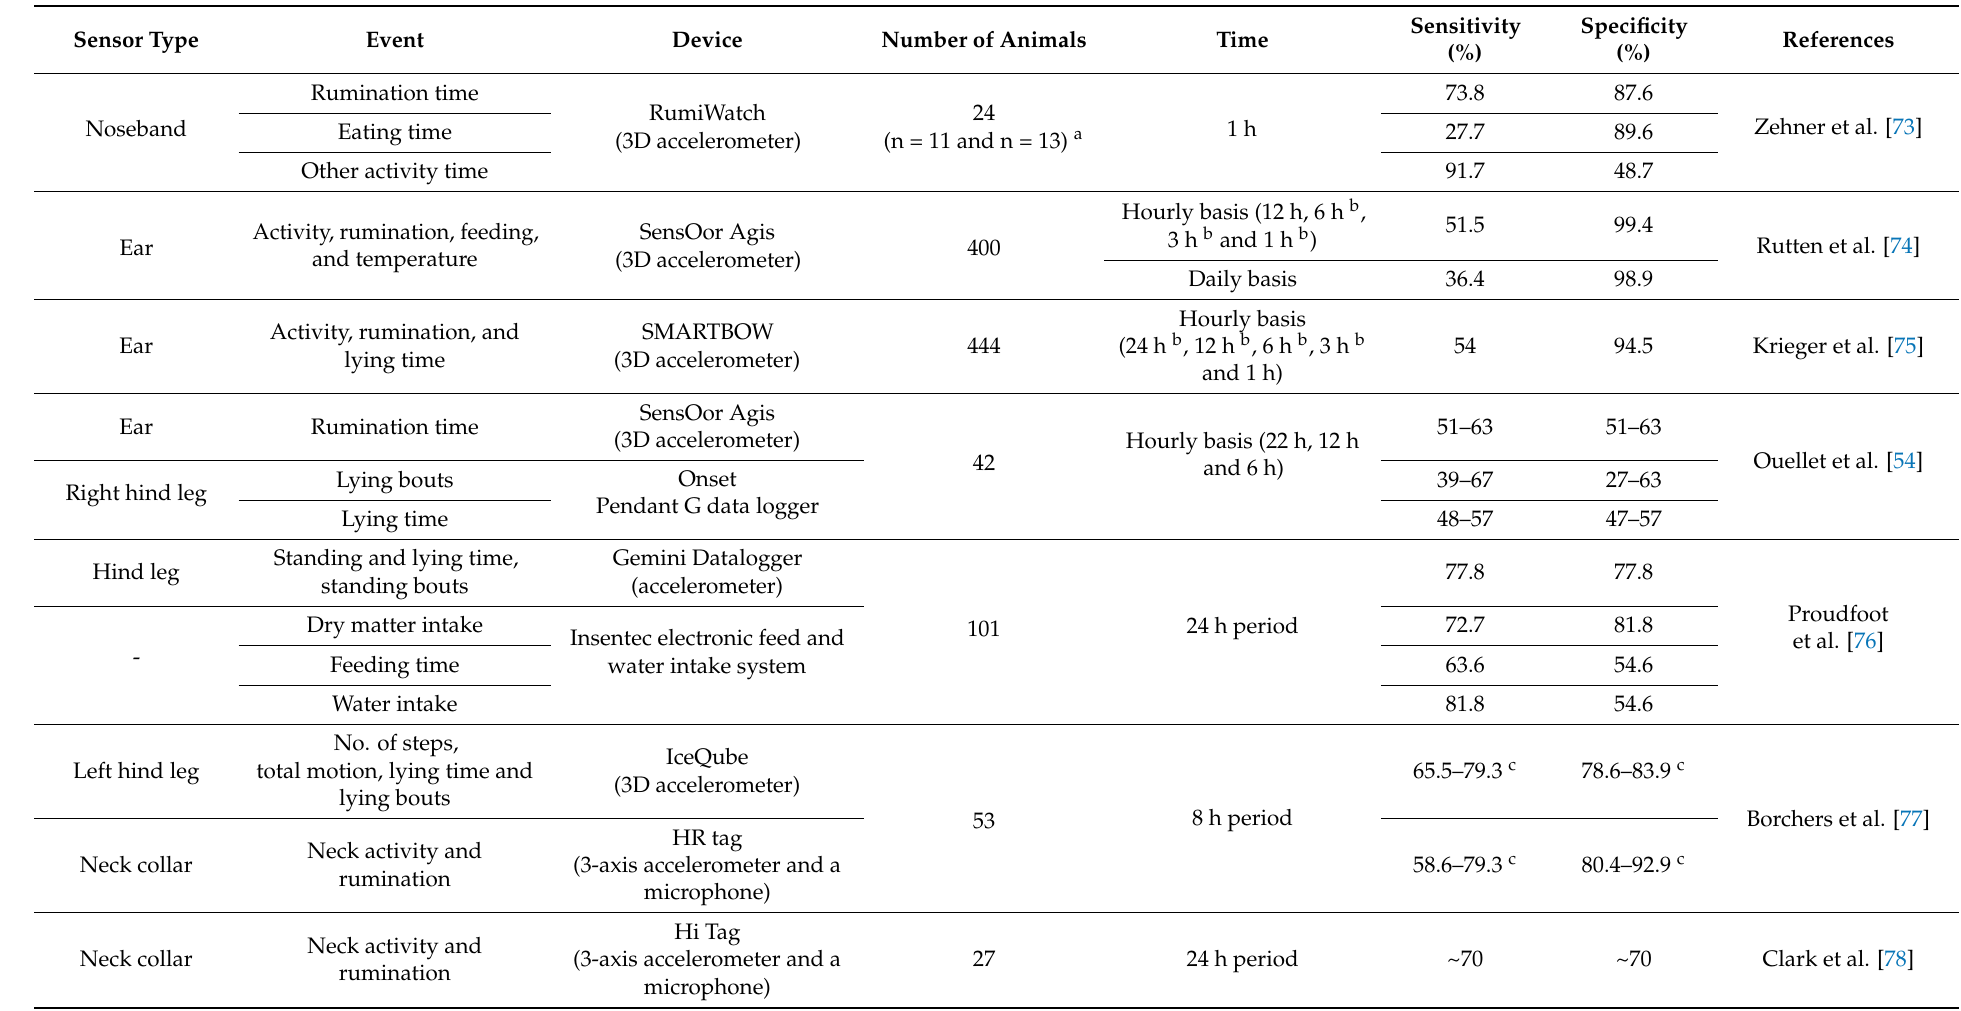
Table 3. Accuracy to predict calving by evaluating the different behavioural signs of imminent calving by using a single sensor in dairy